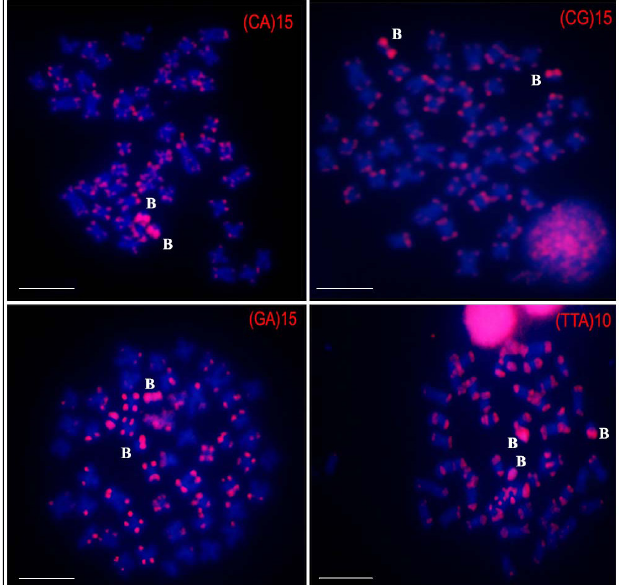
FIGURE 3 | Metaphase plates of Characidium sp. aff. C. vidali after fluorescent in situ hybridization (FISH) with four microsatellite motifs. B chromosomes present in the species are indicated. Scale bar = 10 µm.